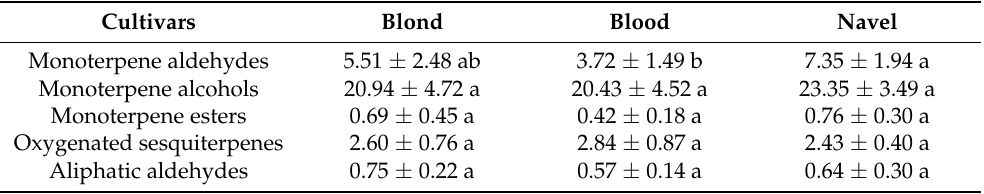
Table 1. Proportion of oxygenated compounds in orange leaf oil for the three types of cultivars. The first number is the mean value, the second is the standard deviation, and the letter is the statistical group according to Tukey’s test ( p ≤